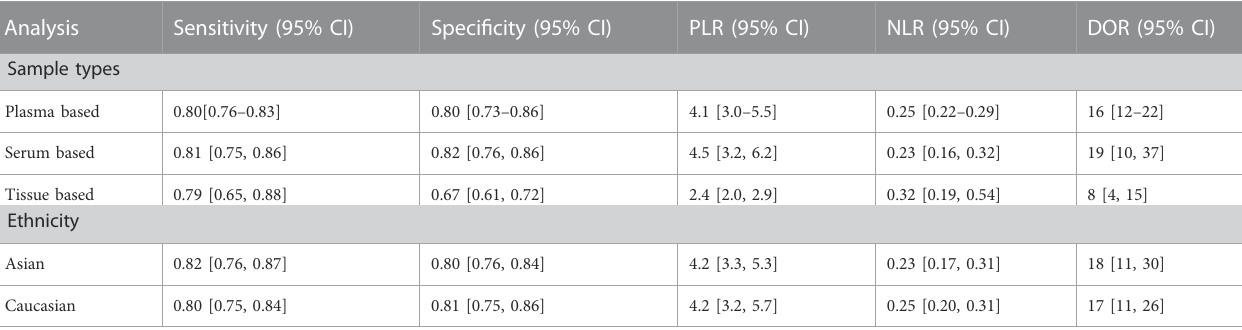
TABLE 5 Diagnostic value of ncRNAs in different sample sources and